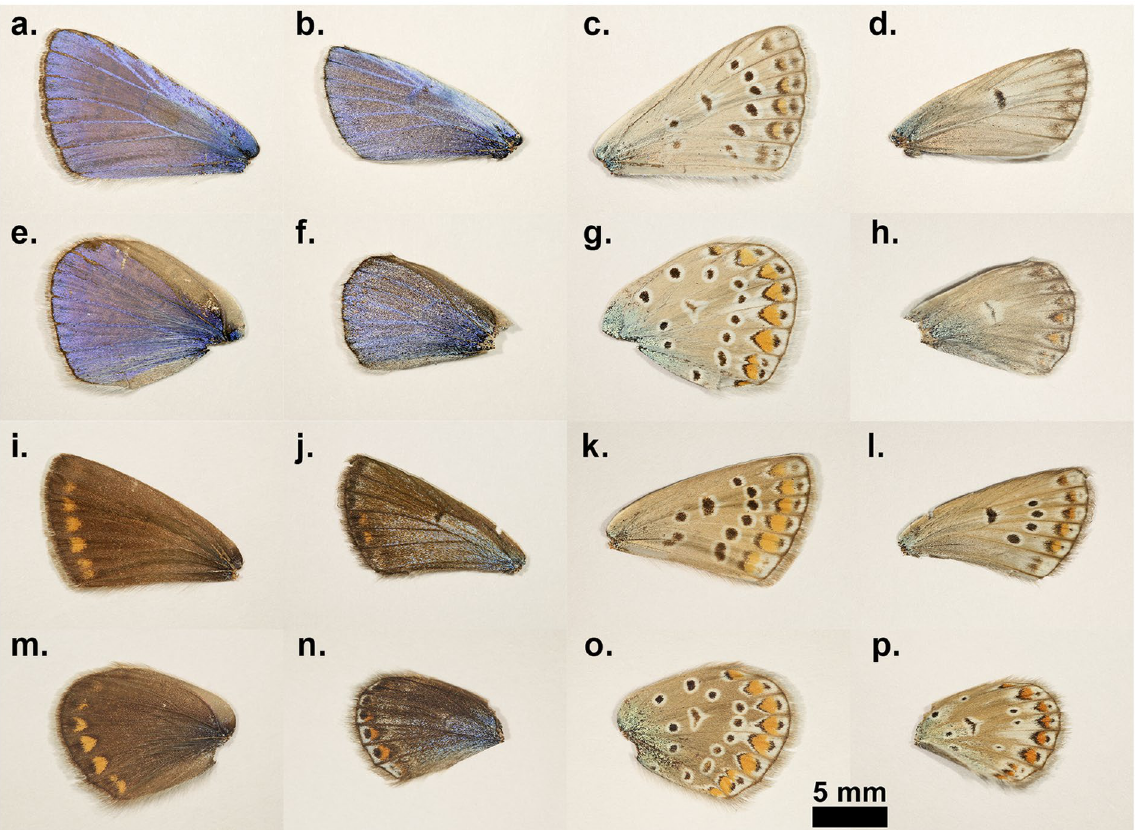
Figure 1. Wings of wild butterflies and of butterflies eclosed form pupae subjected to prolonged cooling at 5 °C in dark. ( a ) Dorsal forewing of a wild male; ( b ) dorsal forewing of a male emerged from a pupa cooled for 62 days; ( c ) ventral forewing of a wild male; ( d ) ventral forewing of a male eclosed form a pupa cooled for 62 days; ( e ) dorsal hindwing of a wild male; ( f ) dorsal hindwing of a male emerged from a pupa cooled for 62 days; ( g ) ventral hindwing of a wild male; ( h ) ventral hindwing of a male eclosed form a pupa cooled for 62 days; ( i ) dorsal forewing of a wild female; ( j ) dorsal forewing of a female emerged from a pupa cooled for 40 days; ( k ) ventral forewing of a wild female; ( l ) ventral forewing of a female eclosed form a pupa cooled for 40 days; ( m ) dorsal hindwing of a wild female; ( n ) dorsal hindwing of a female emerged from a pupa cooled for 40 days; ( o ) ventral hindwing of a wild female; ( p ) ventral hindwing of a female eclosed form a pupa cooled for 40